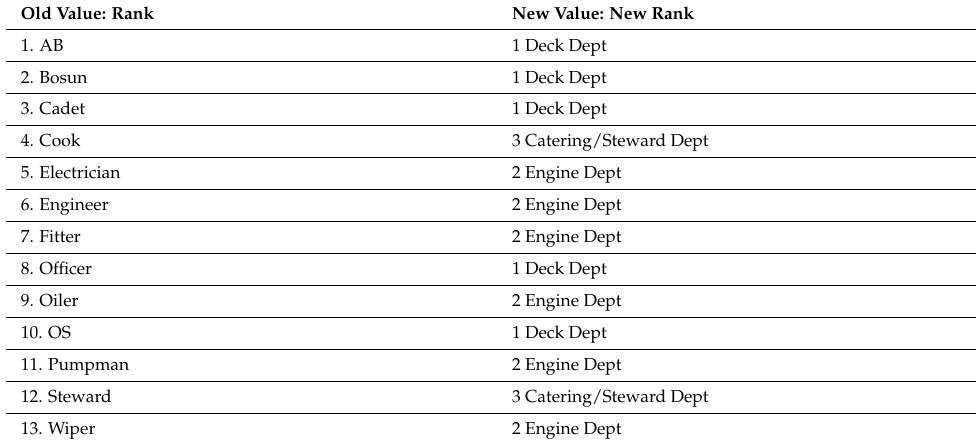
Table 1. Definition of new